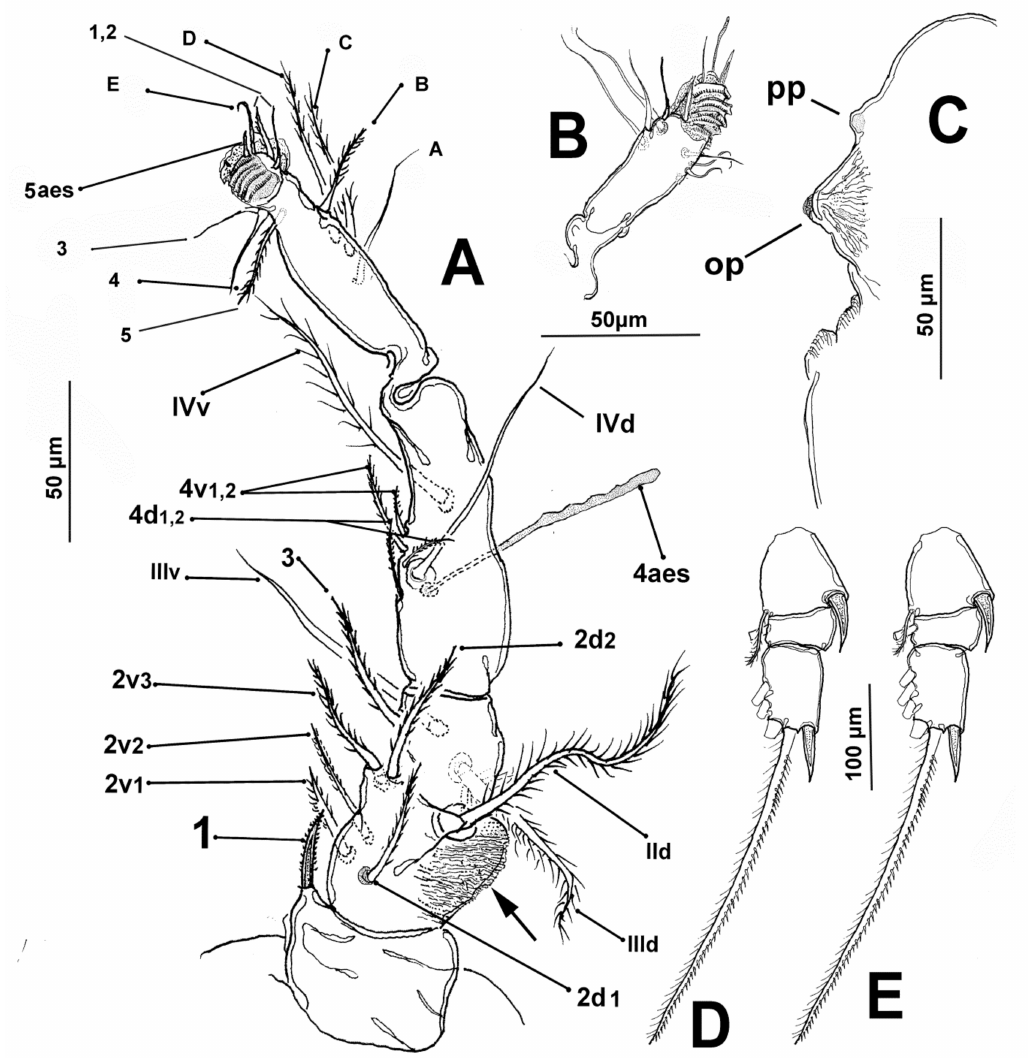
Figure 3. Caromiobenella brasiliensis (Dias and Su á rez-Morales, 2000) comb. nov., from Rio de Janeiro area, adult male (MNRJ30136). ( A ) Right antennule, dorsal view showing setal elements (segments 1–4 [14], segment 5 [1]; ( B ) Left fifth antennulary segment; ( C ) Anterior part of cephalothorax, lateral view (pp = preoral process, op = oral papilla); ( D ) Leg 1 exopod; ( E ) Leg 3 exopod. Arrow indicates wrinkled outer process on second segment. Legend: pp = preoral process, op = oral